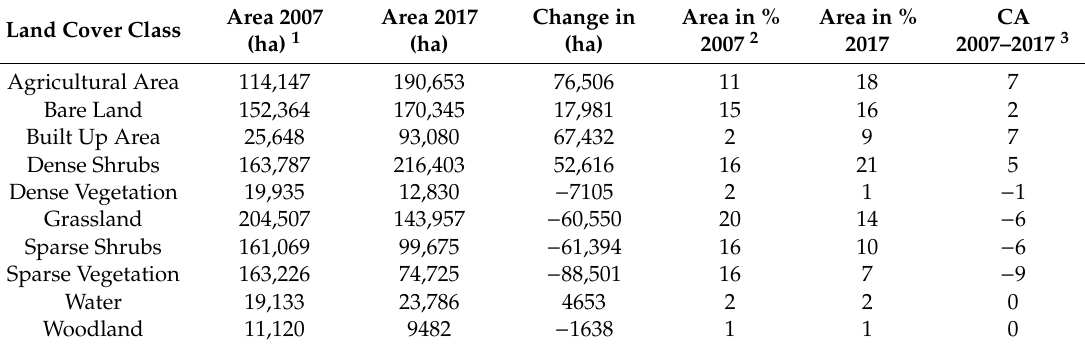
Table 1. Landcover change in Gonarezhou National Park between 2007 and 2017